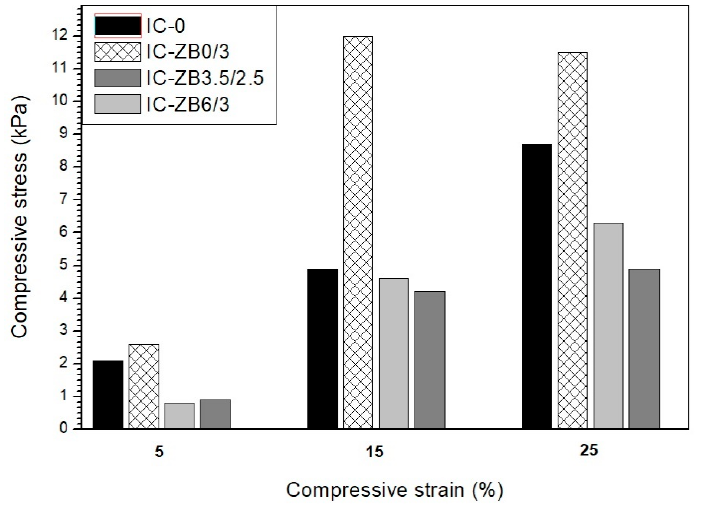
Figure 10. Compressive stress (at the selected strain) for the charred intumescent coatings with various zinc borates.